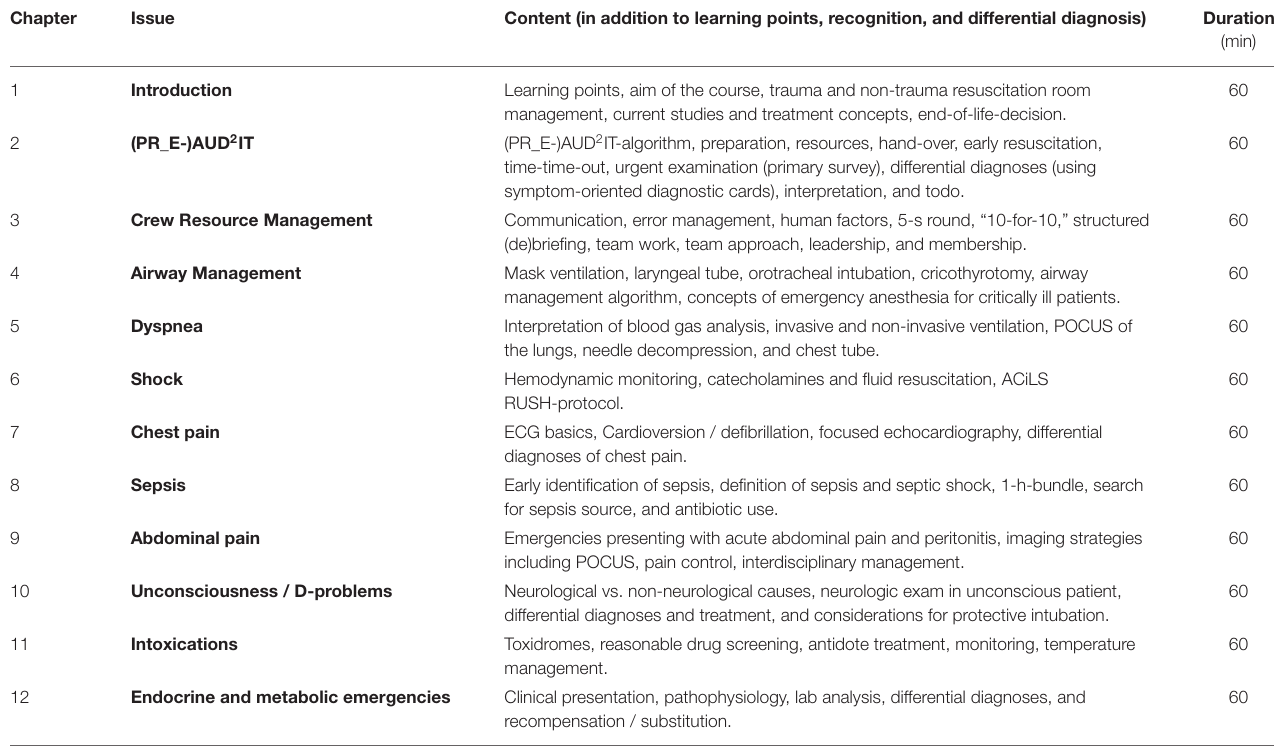
TABLE 3 | E-learning part of the “Advanced Critical illness Life Support” course. Chapter Issue Content (in addition to learning points, recognition, and differential diagnosis) Duration